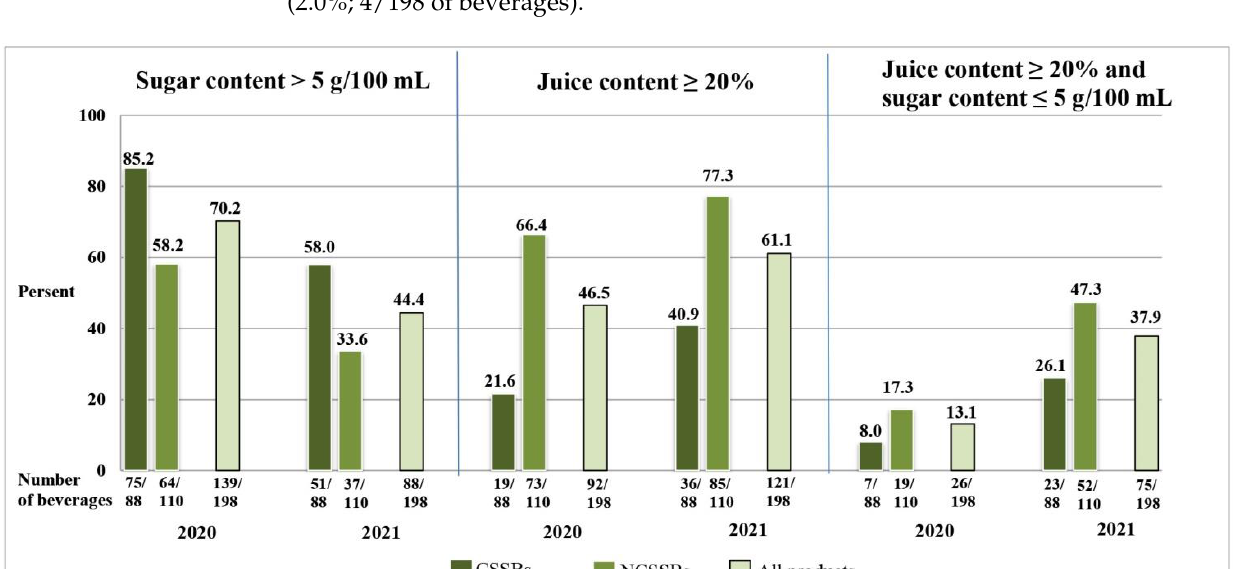
Table 1. The characteristics of SSBs in both study periods.